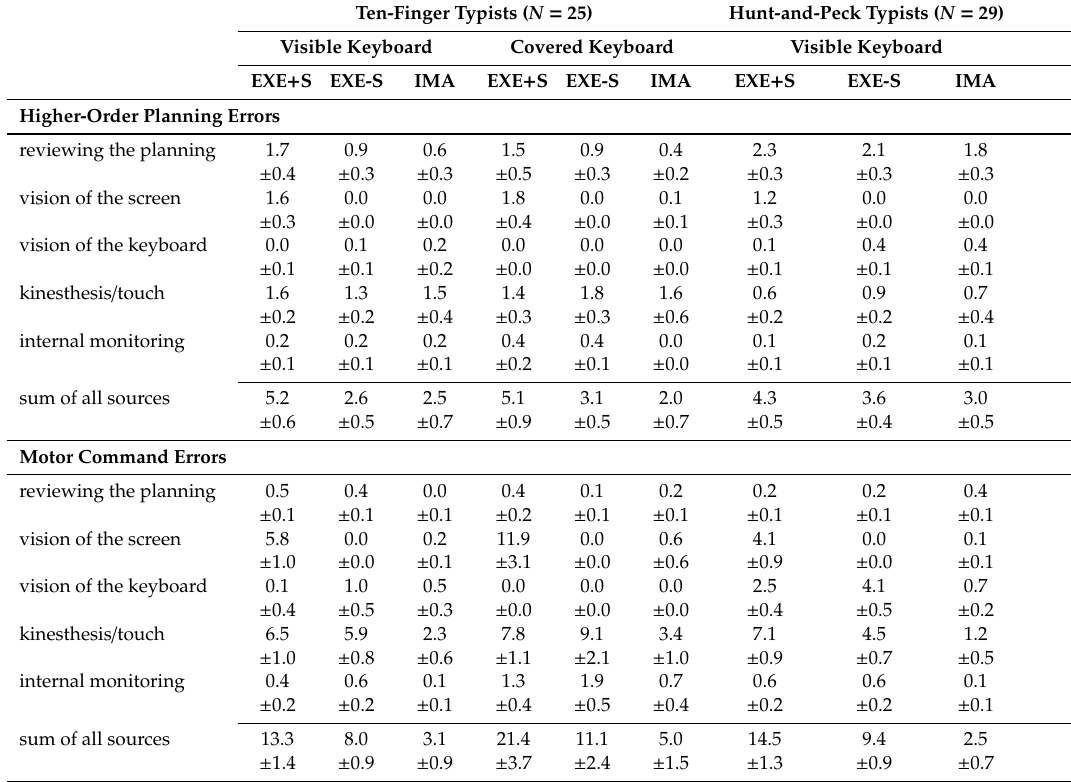
Table 2. Means and standard errors ( ± ) of the number of reported errors depending on typing style (ten-finger typists and hunt-and-peck typists), action condition (execution with visible screen [EXE + S], execution with covered screen [EXE-S], and imagination [IMA]), keyboard (visible and covered), error type (higher-order planning and motor command), and error detection source (reviewing the planning process, vision of the screen, vision of the keyboard, kinesthesis / touch, and internal monitoring). Note that hunt-and-peck typists did not perform the conditions in which the keyboard was covered. Ten-Finger Typists ( N = 25) Hunt-and-Peck Typists ( N = 29) Visible Keyboard Covered Keyboard Visible